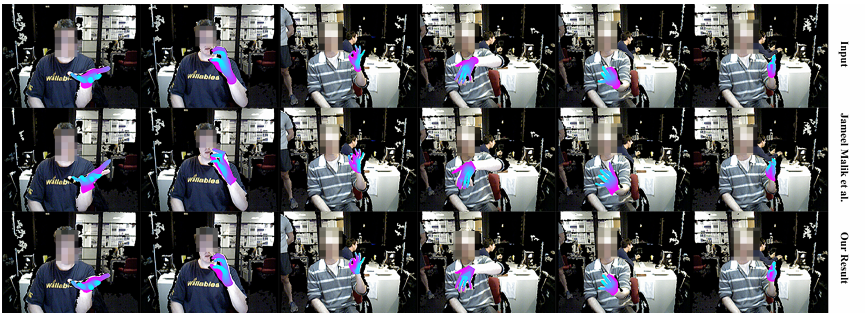
Figure 28. The qualitative comparison between our system with Malik et al. [2] on the NYU data-set. The first row shows the hand segment of the input depth after pseudo-color enhancement; the second row shows the rendered depth image from the recovered hand model of Malik et al. [2]; the bottom row shows the rendered depth image from the recovered hand model of our